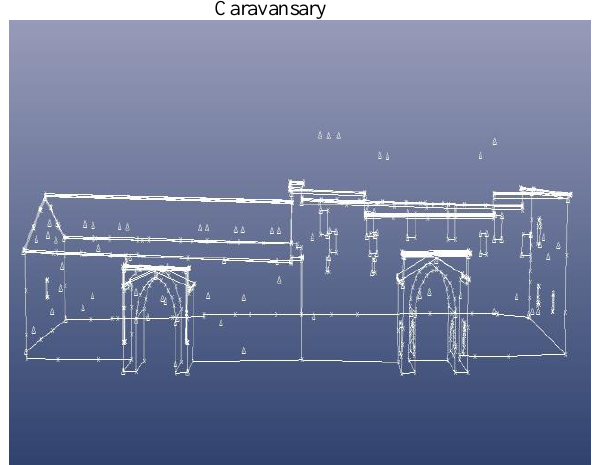
Figure 2. Control points and drawing of Caravansary